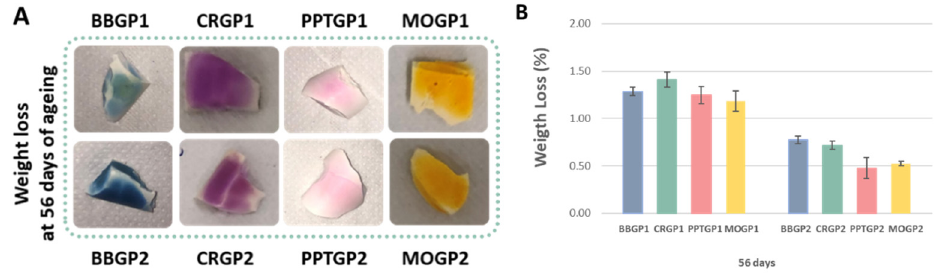
Figure 11. ( A ) Coloured geopolymers images after the weight loss tests. ( B ) Coloured geopolymer weight loss (%) at 56 days of ageing.